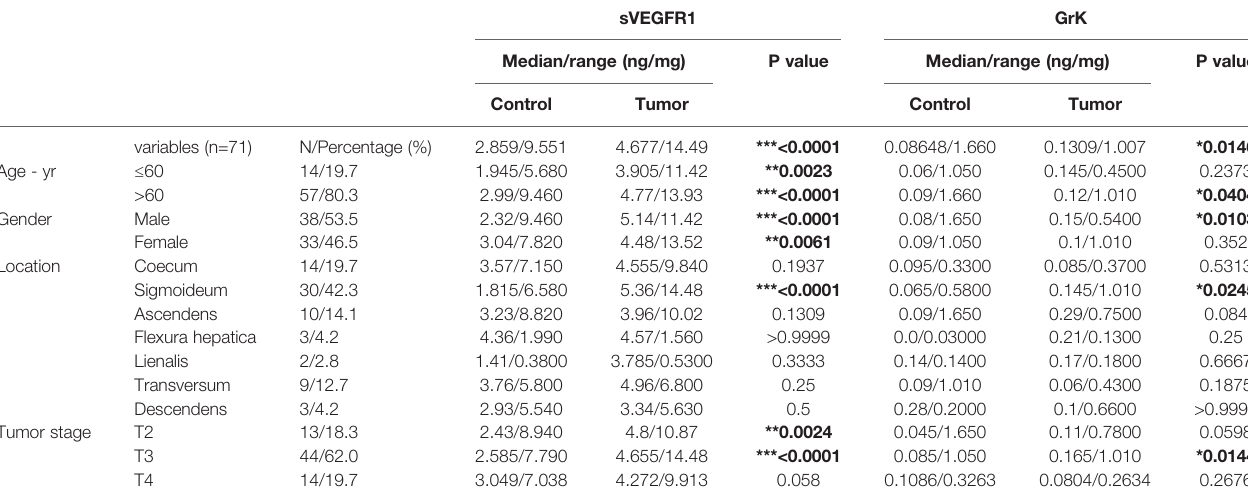
TABLE 1 | Protein levels of sVEGFR1 and GrK in colorectal